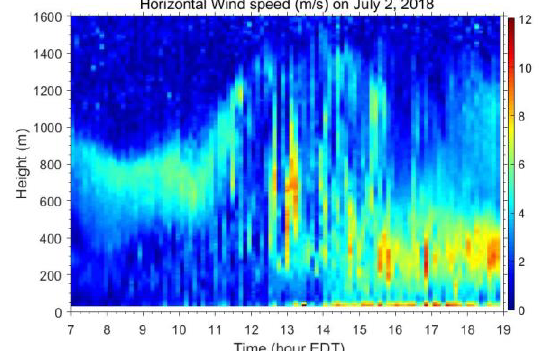
Fig. 4 Halo Pro Horizontal Wind Speed